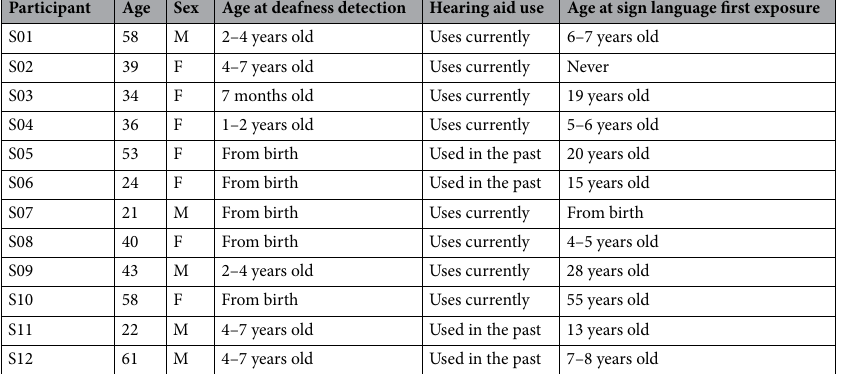
Table 1. Demographic information about deaf participants obtained through self-report